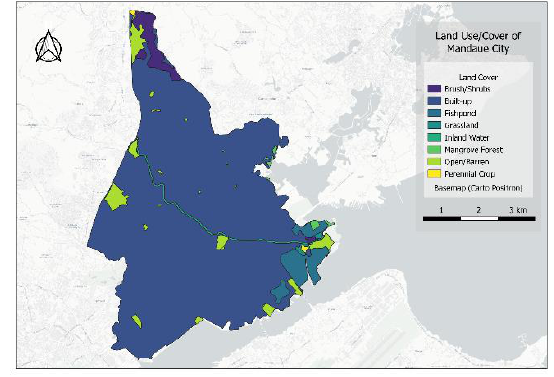
Figure 9. Land cover map of Mandaue City